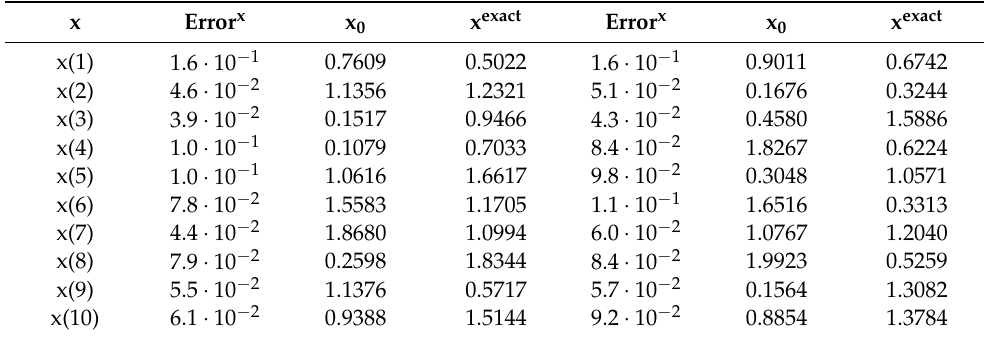
Figure 8. Errors of the computed degradations, Error x , as obtained by repeating the computations displayed in Table 8 one hundred times, with randomly chosen exact degradations and initial conditions for the adapted Newton method. Table 9. Counterpart of Table 8 when adding random noise to the sensors data. The temperature T 4 t is computed with an error ∼ 0.2